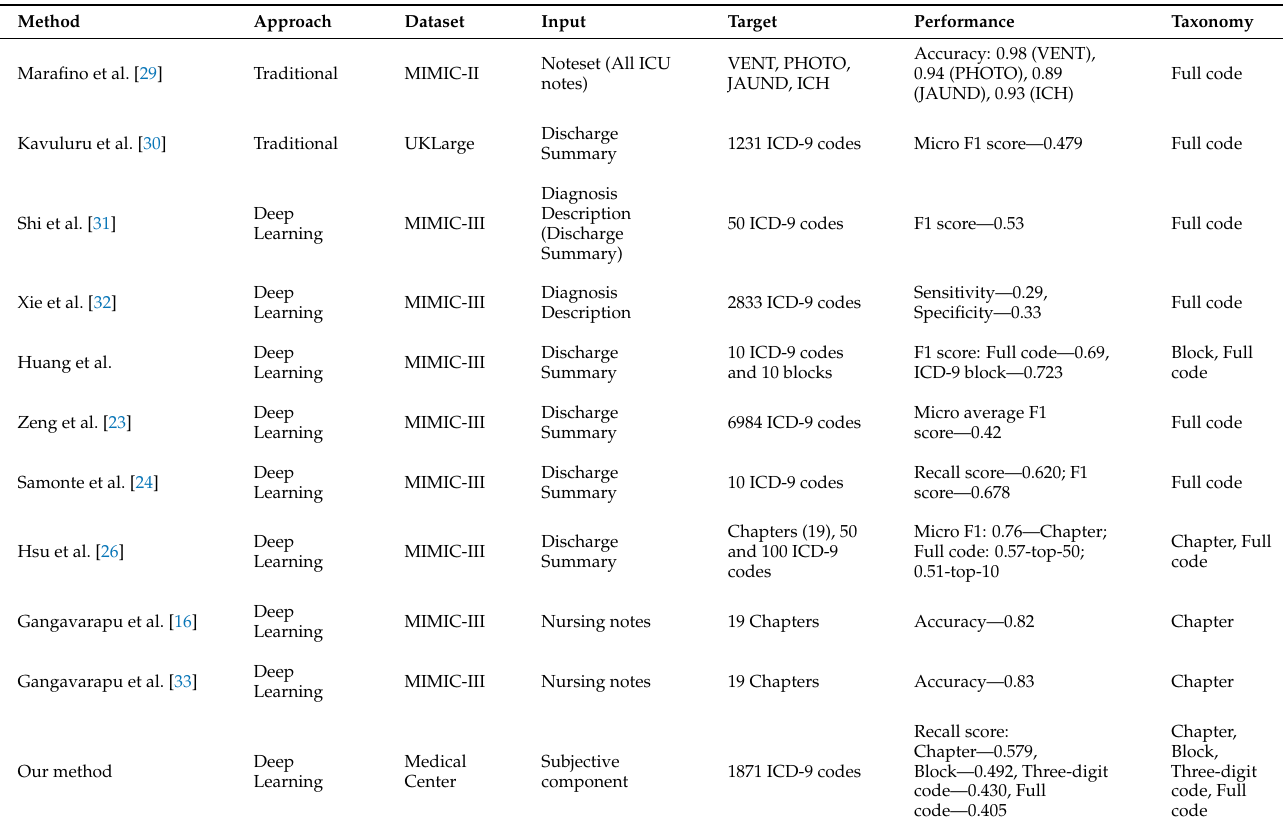
Table 2. Comparison with other